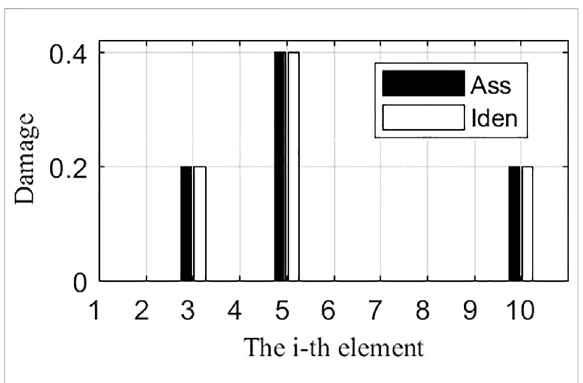
FIGURE 5 Mean values of SDD results in case 3 based on (0.1* SObj 4 + 0.9* SObj